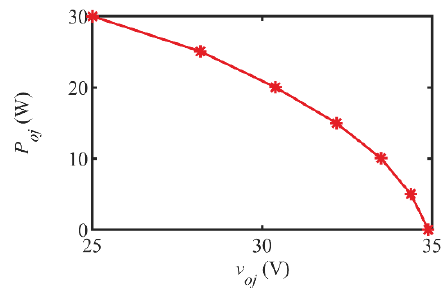
Figure 11. Output characteristic curve.